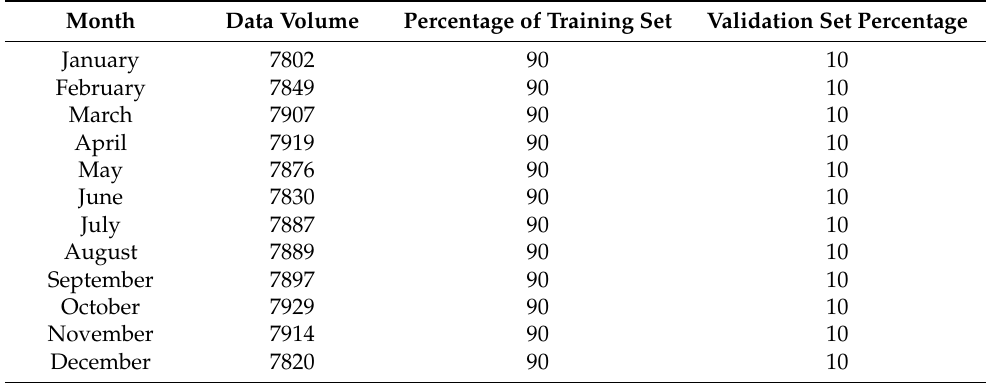
Table 3. The data volume for each month and the proportion of the training and validation data